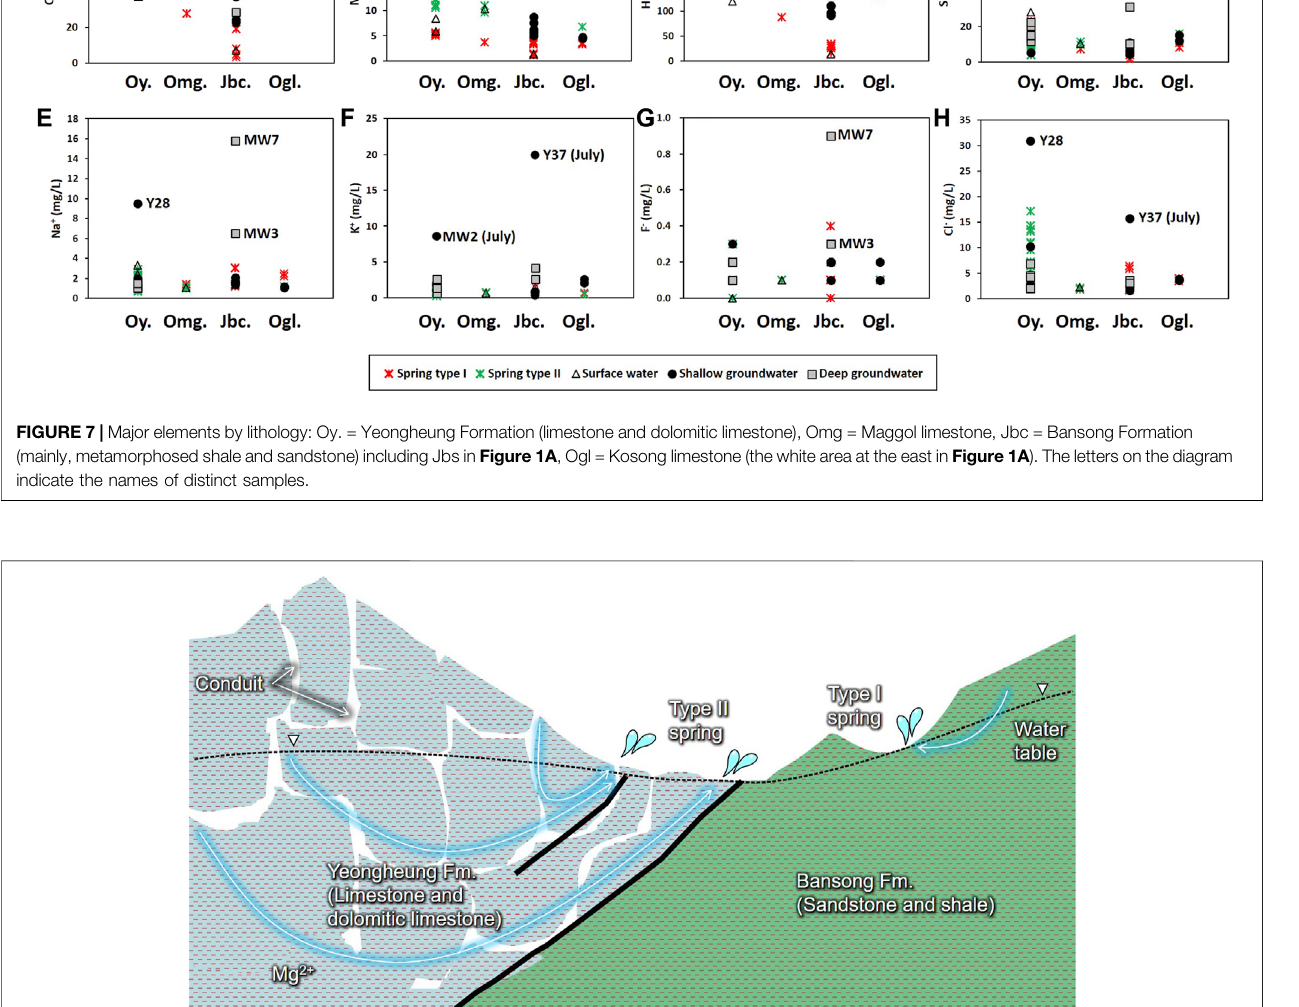
Frontiers in Earth Science |